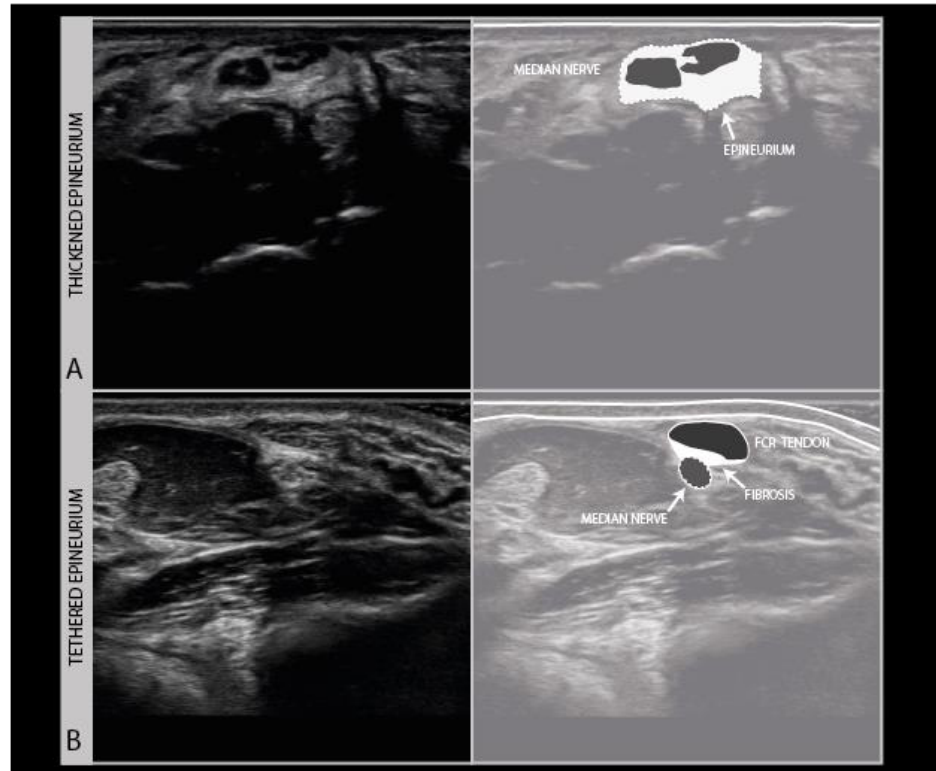
Figure 9. Persistent median neuropathy with very thick epineurial rim and hypoechogenic, swollen nerve fascicles, in a female patient who underwent 30+ carpal tunnel release surgical procedures ( A ). Median nerve adhesion in the distal forearm; the superficial epineurium of the nerve is tethered to the flexor carpi radialis tendon sheath directly on top of the nerve (hyperechoic region between the tendon and nerve) ( B ).